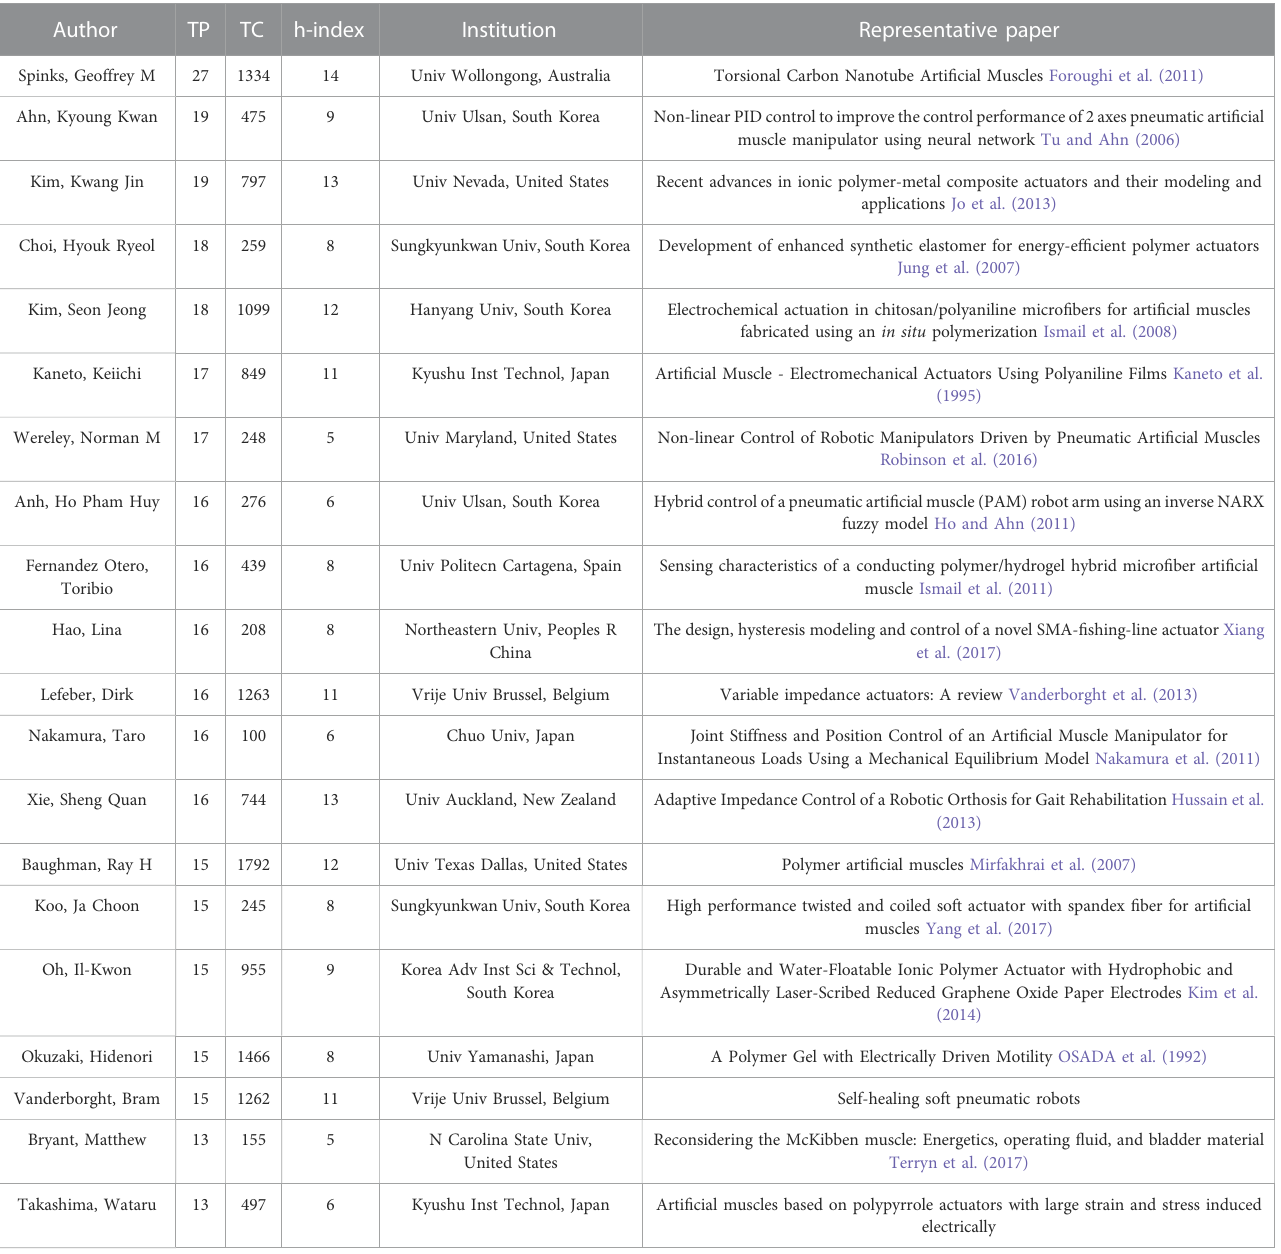
TABLE 2 Contribution of the top 20 most productive authors in arti fi cial muscle